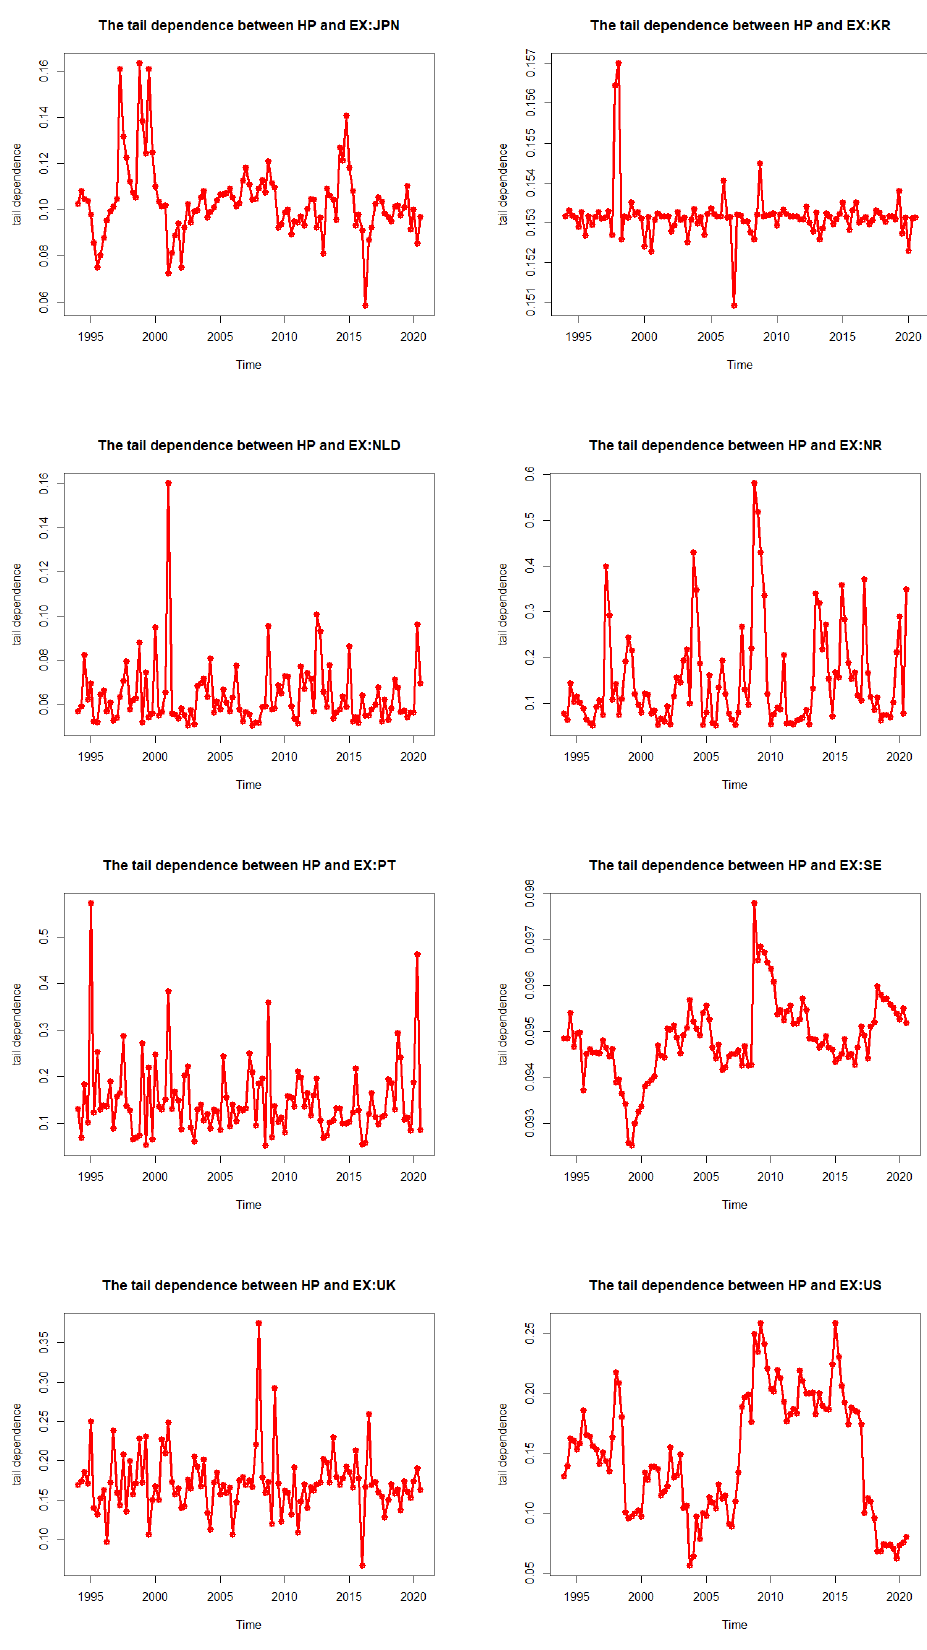
Figure 2. The tail dependence between house prices and exchange rates for OECD countries.